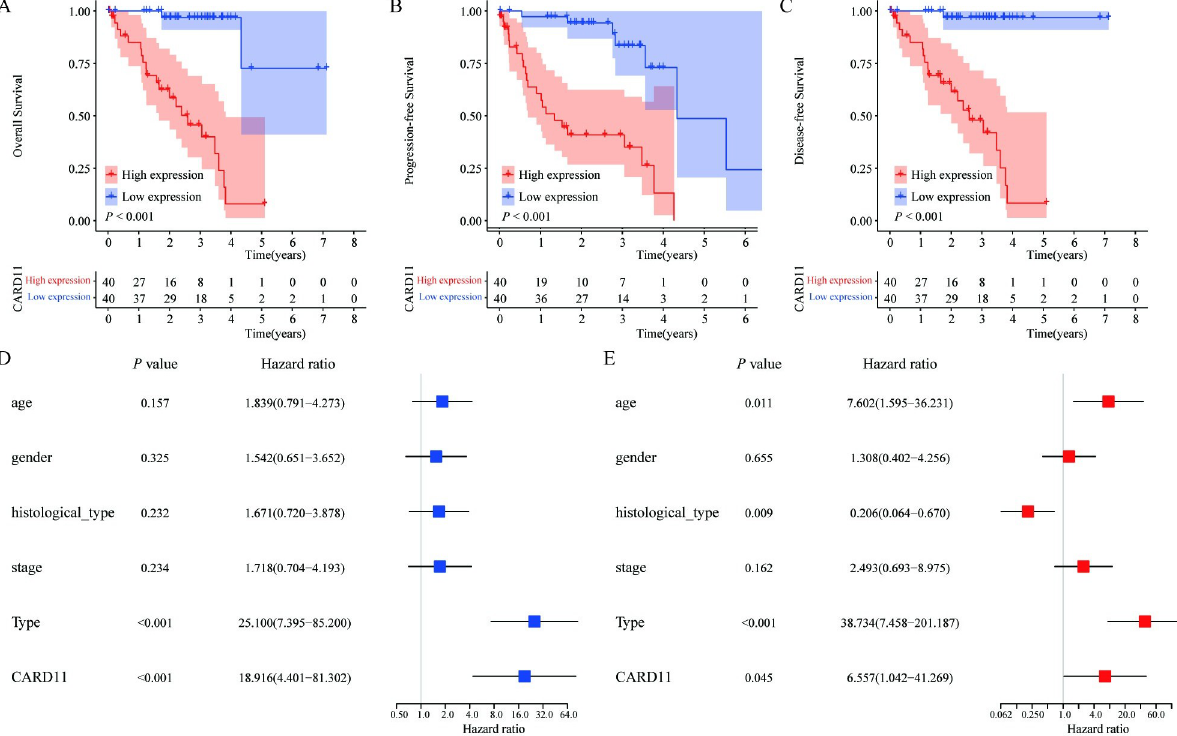
Fig 2. Influence of CARD11 expression on the prognosis of UVM patients. ( A-C ) Kaplan-Meier analysis showed that the OS, PFS, and DFS in CARD11 high-expression group were lower (log-rank P < 0.001), comparing with that in CARD11 low-expression group. ( D, E ) The univariate and multivariate Cox regression analysis combined CARD11 expression with clinicopathological characteristics showed that CARD11 was an independent risk factor for